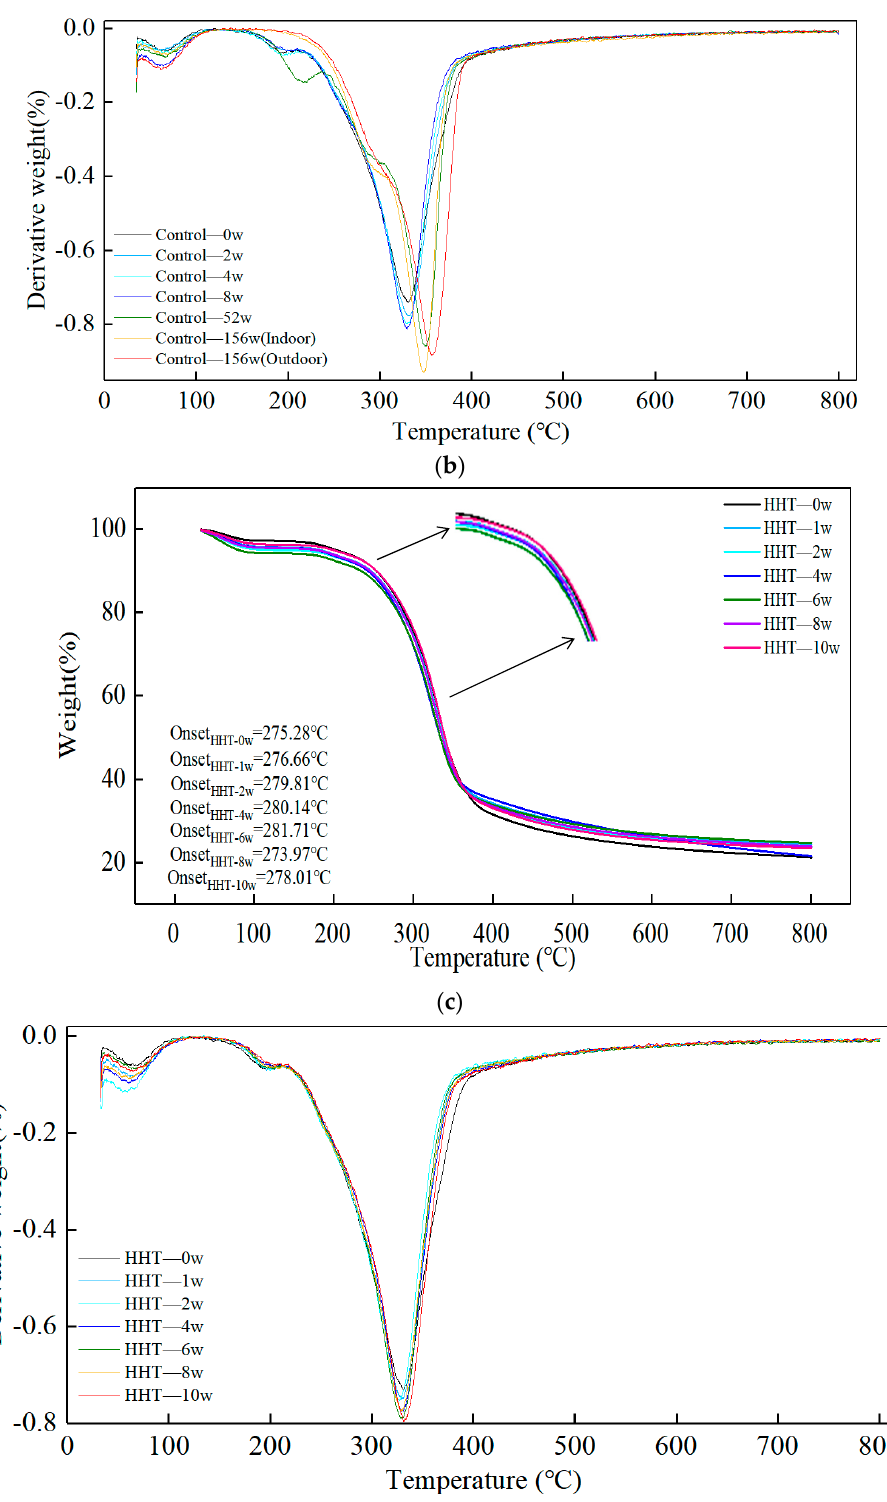
Figure 12. Effect of humid heat ageing and natural ageing on the thermal stability properties of bamboo. ( a ) Thermogravimetric analysis of control group samples during storage ( b ) Derivative Thermogravimetry of the control group samples during storage. ( c ) Thermogravimetric analysis of treatment group samples during storage. ( d ) Derivative Thermogravimetry of the treatment group samples during storage.